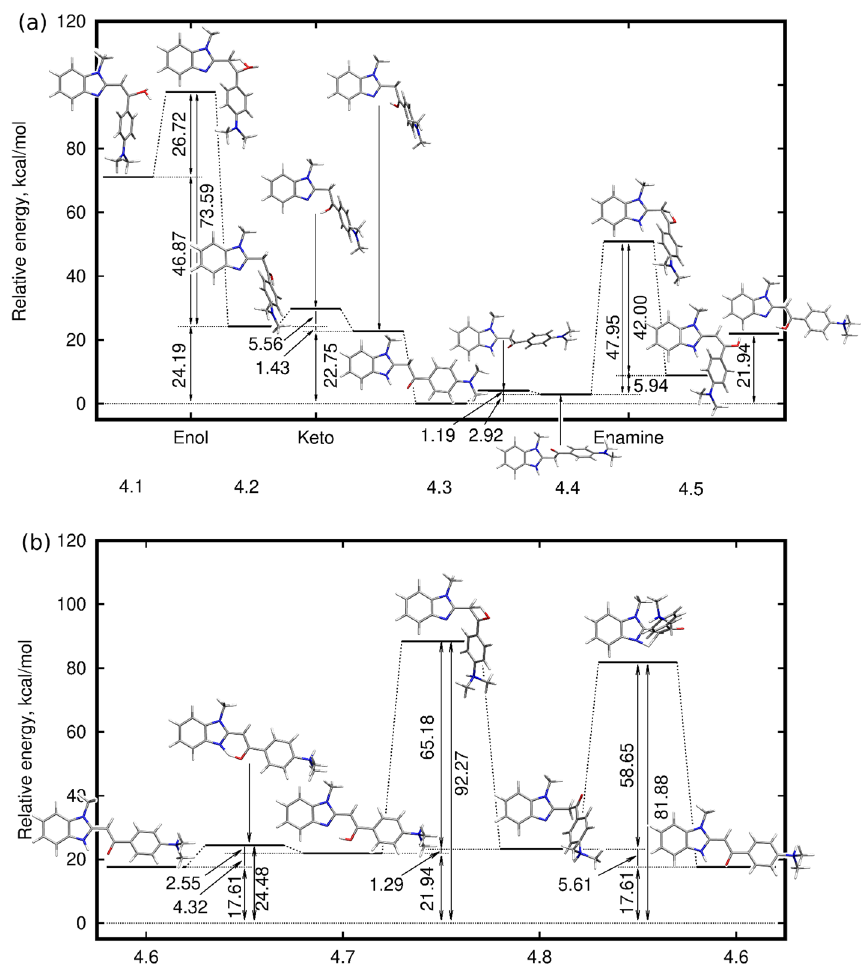
Figure 6. Mechanism of possible proton transfer processes in [ 4 +H] + ion calculated within the ω B97X-D/6- 311++G(d,p) approach ( a ) protonation of the main part of the molecular core at N7, C10, O13; ( b ) protonation of the terminal dimethylamine substituent at N26. The relative energy for all the structures presented in both panels is given with respect to the same lowest energy 4.3 form bearing protons at N7 and